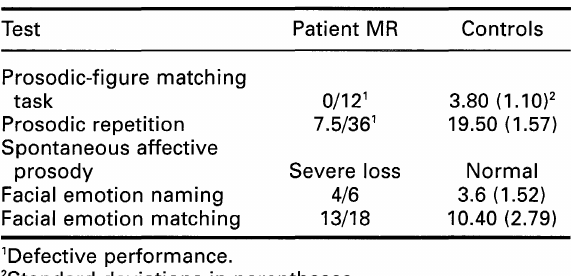
TABLE III. Affective language